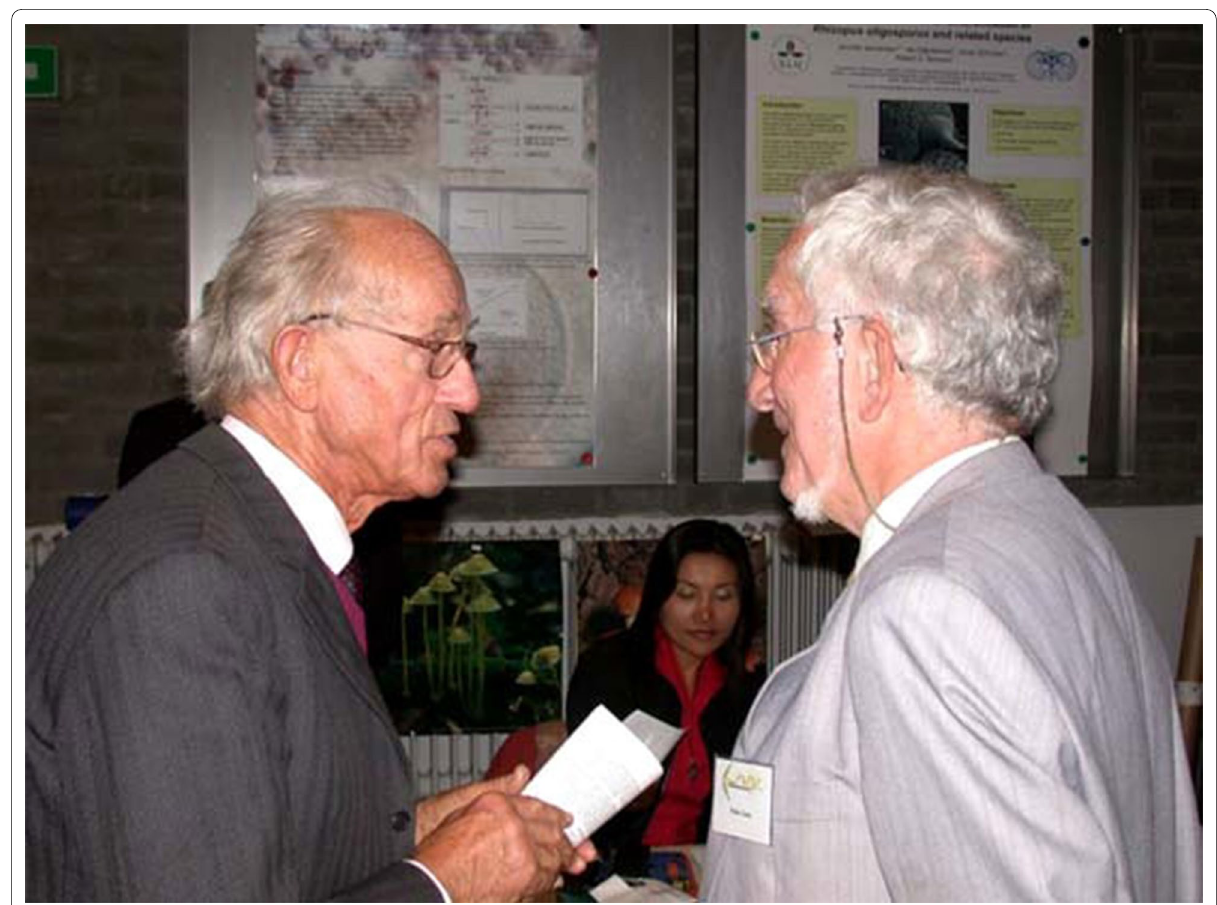
Fig. 25 Grégoire Hennebert ( left ) and Walter Gams ( right ) chatting at the centenary symposium of the Centraalbureau voor Schimmelcultures (now Westerdijk Fungal Biodiversity Institute) in Amsterdam, 2004. Photo: Pedro